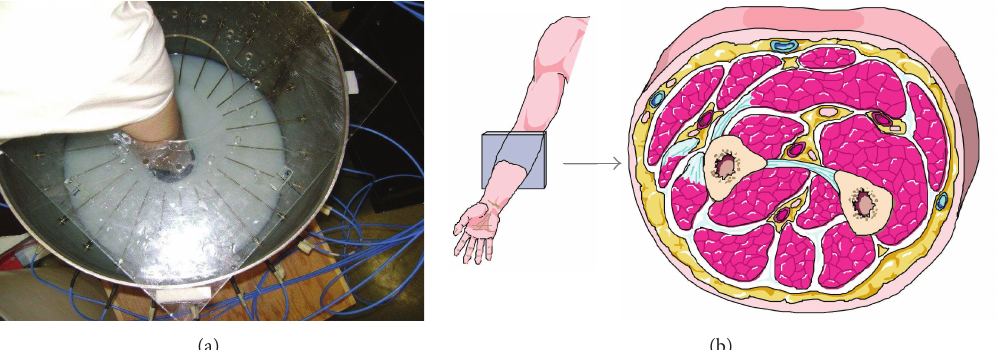
Figure 3: (a) A volunteer’s arm inside the microwave imaging system. (b) Forearm anatomy, with the approximate location of microwave imaging